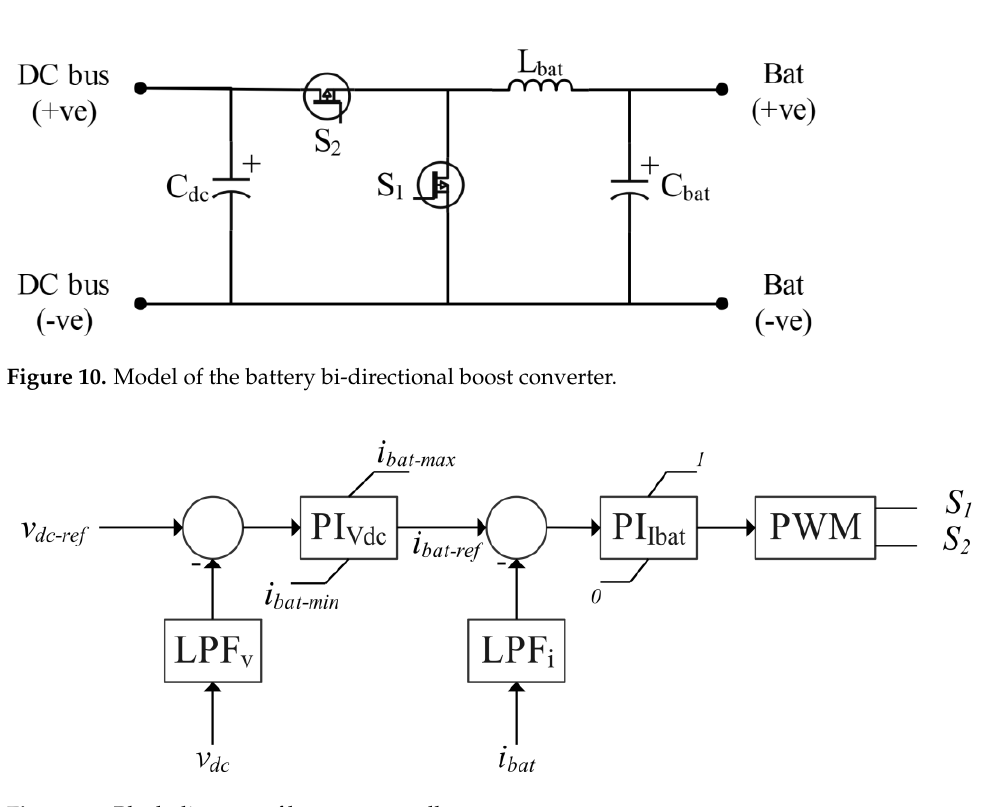
Figure 11. Block diagram of battery controller.